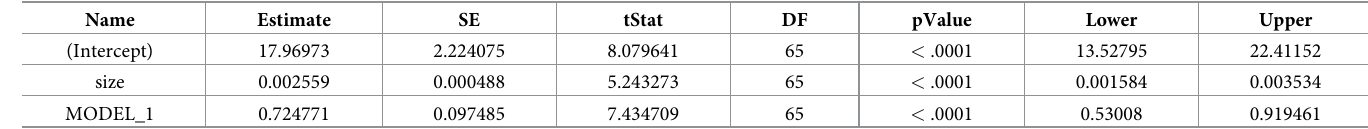
Table 6. The fixed effects coefficients of the model explaining the tour cost in terms of the HPN+2opt/GPN+2opt and the problem size. Name